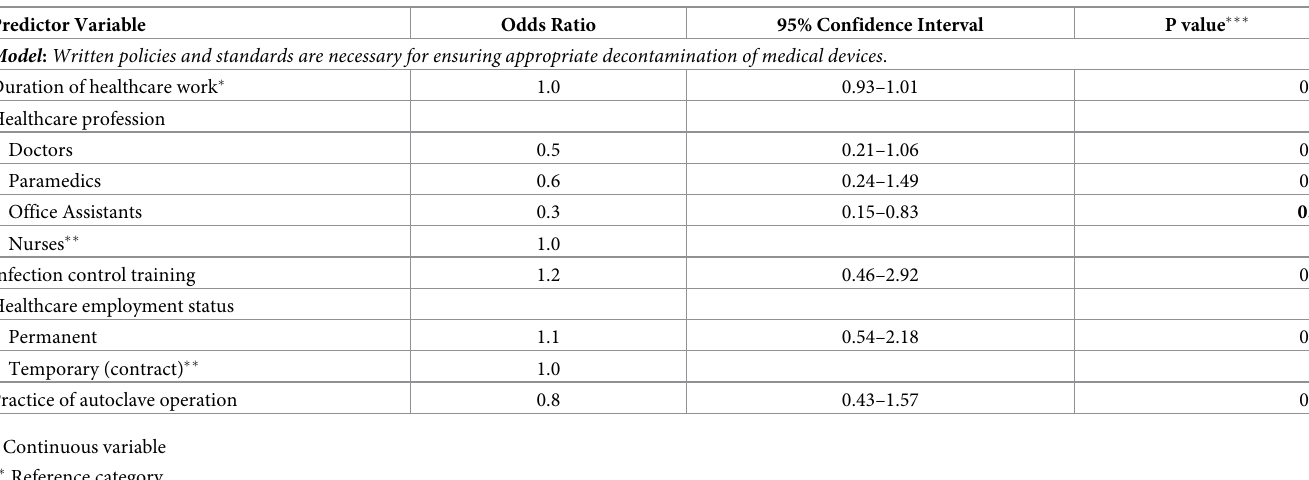
Table 8. Complex samples—ordinal regression model for the attitude of healthcare workers towards policies and standards. Predictor Variable Odds Ratio